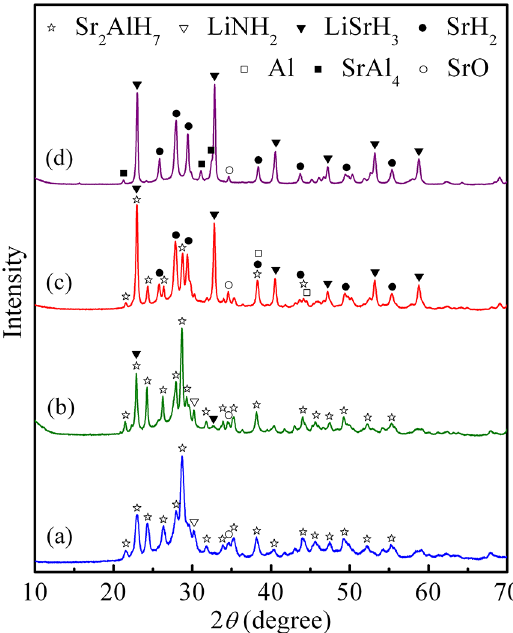
AlH + LiNH mixture as-milled 2 7 2